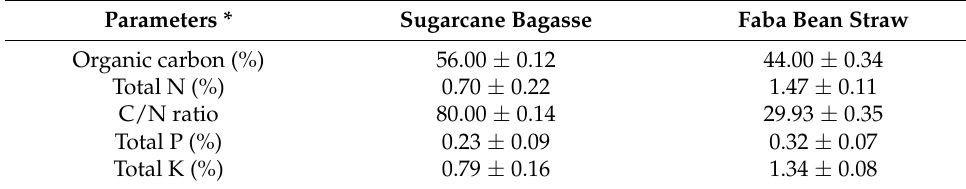
Table 1. Chemical analysis of the two agro-residues used in this study. Parameters